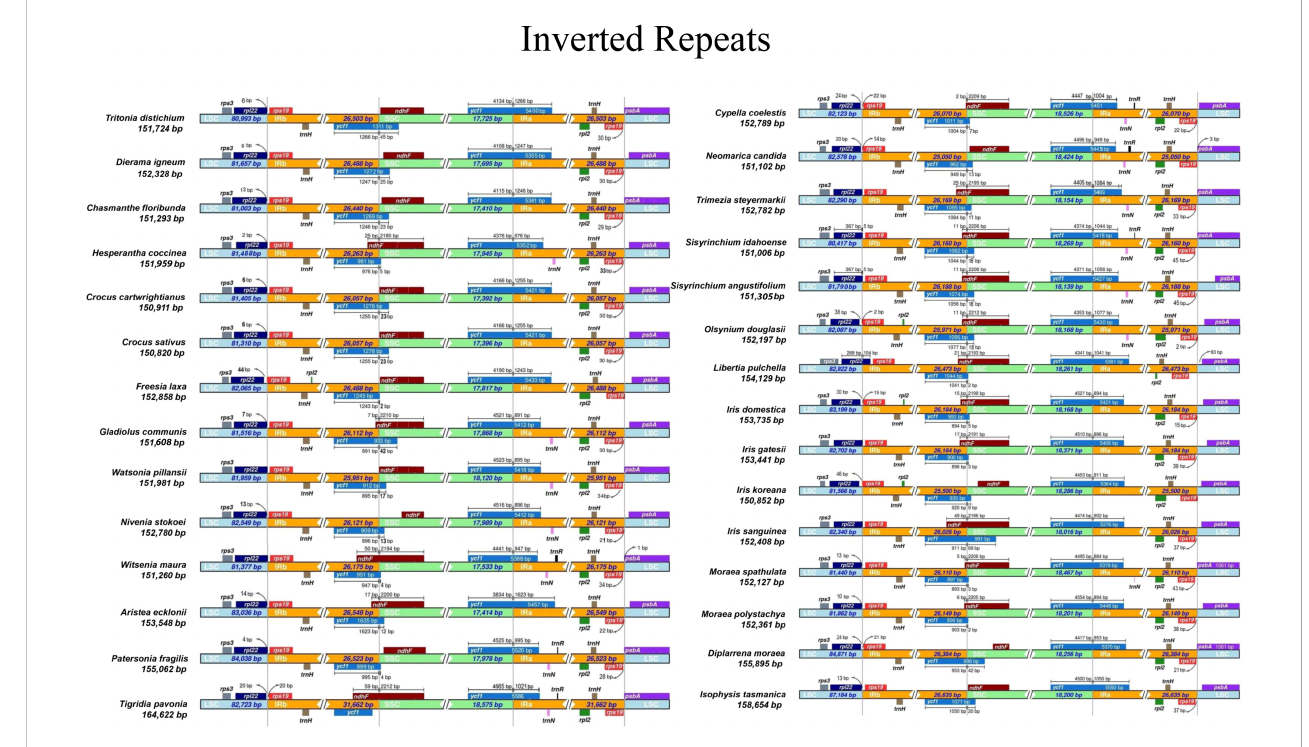
FIGURE 4 Comparison of the borders of large single copy, small single copy, and inverted repeat regions of chloroplast genomes of